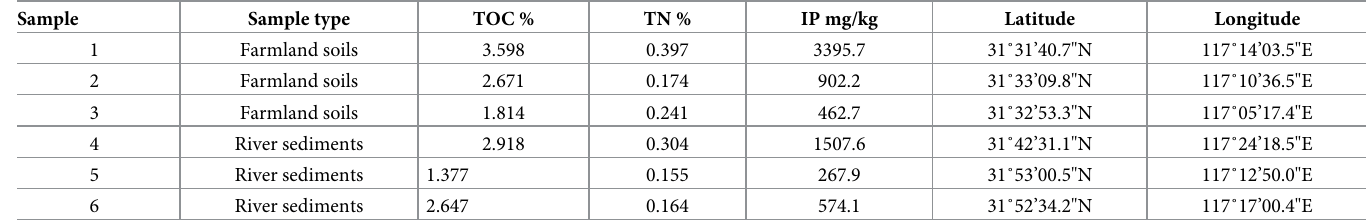
Table 1. TOC, TN and IP in the samples of this